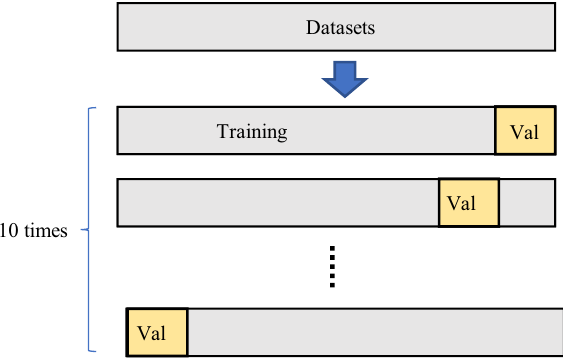
Figure 13. Cross-validation diagram.